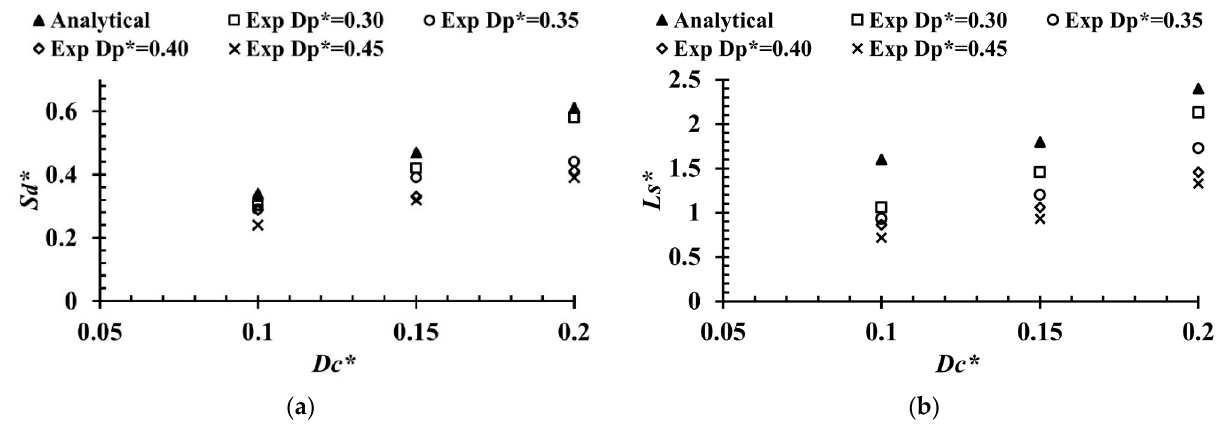
Figure 8. ( a ) Relation between maximum scour depth ( S d * ) and ( b ) length ( L S* ) and dimensionless overtopping depth ( Dc * ) during NM case. overtopping depth ( Dc * ) during NM